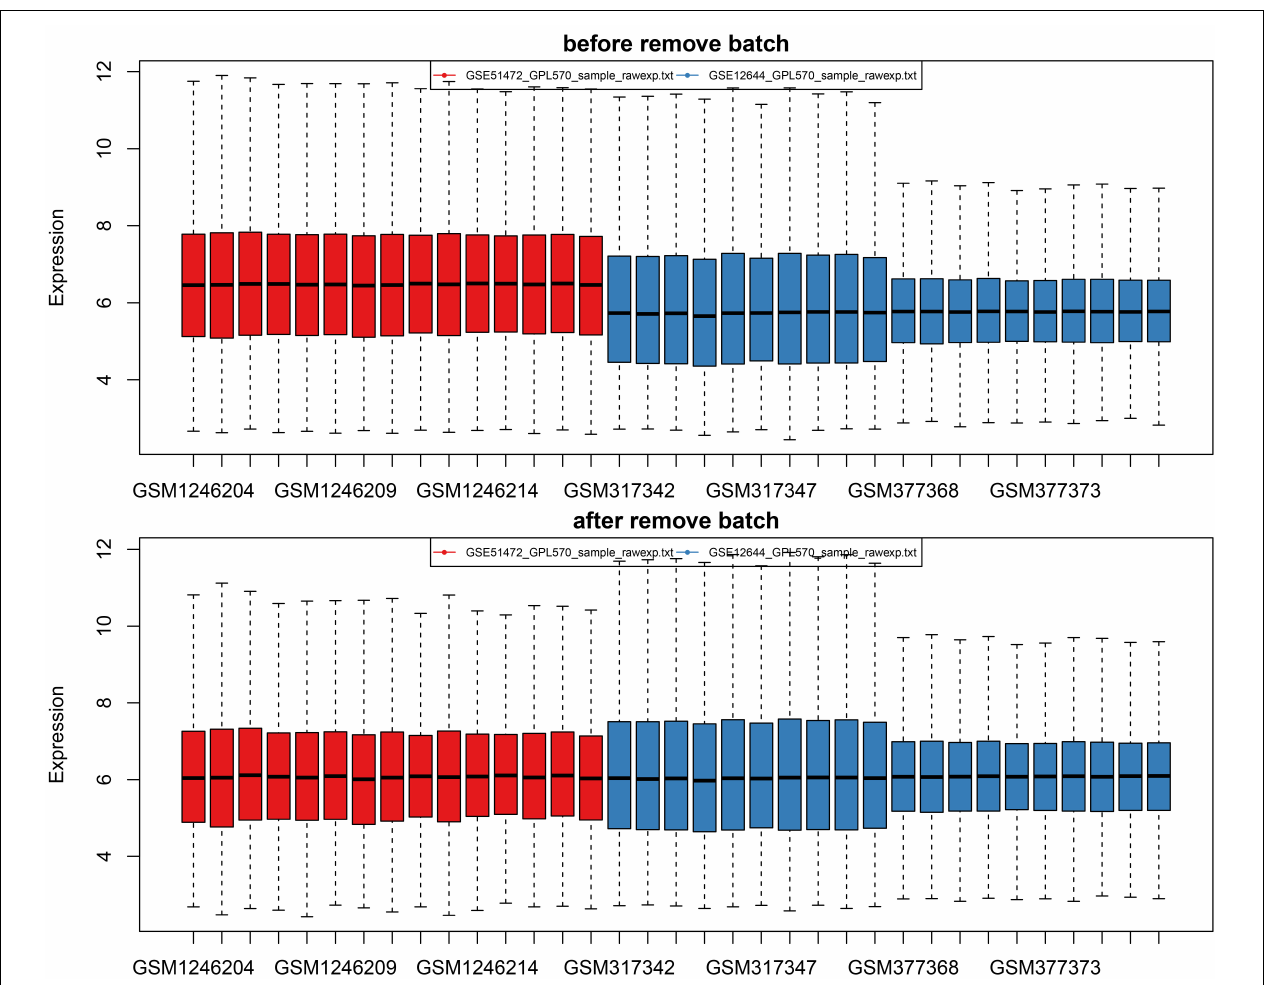
FIGURE 1 | There are two batches of samples in the original data as revealed by the box plot and the expression profile was successfully standardized to a comparable level by pretreatment and batch-effects adjustment.